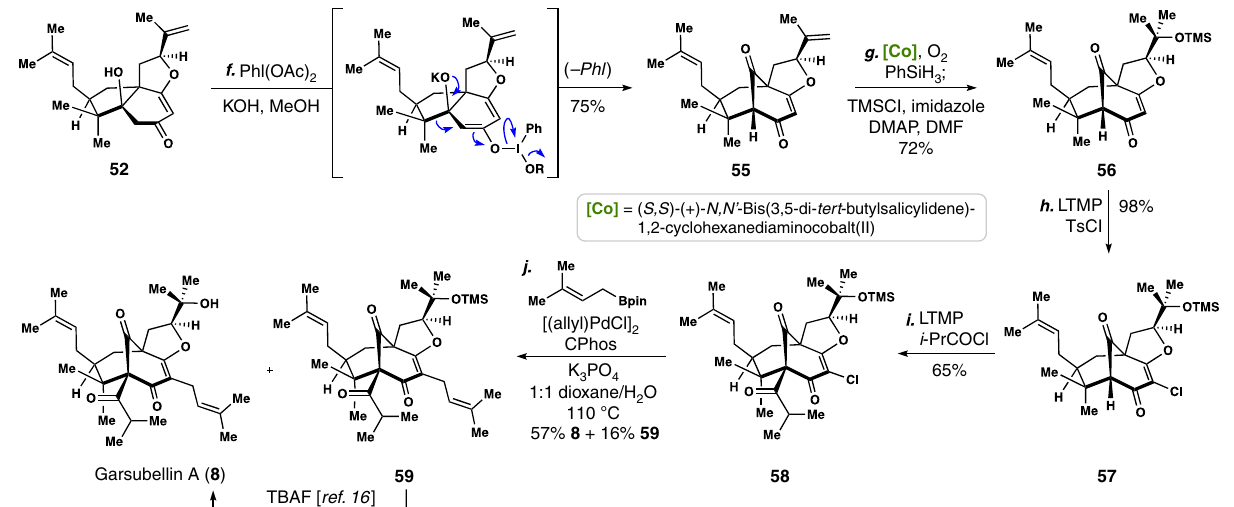
Fig. 5 Total synthesis of garsubellin A. An oxidative ring expansion constructs the key bicyclo[3.3.1] nonane core framework and enables a 10-step route to the